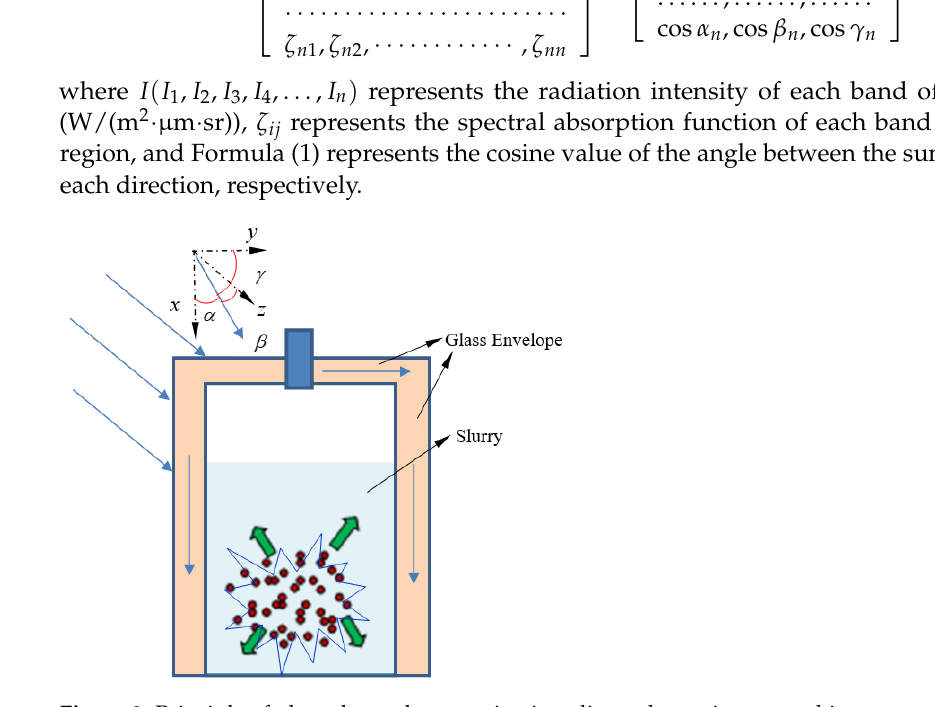
Figure 2. Principle of photothermal conversion in a direct-absorption anaerobic